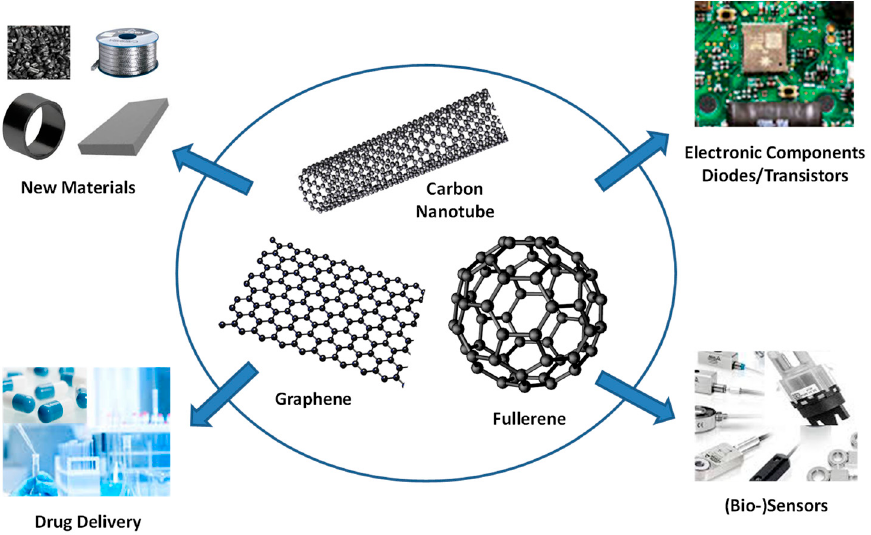
Figure 17. Morphology and main applications of some carbon based nanoplatforms (carbon nanotubes, graphene, fullerene) for emerging